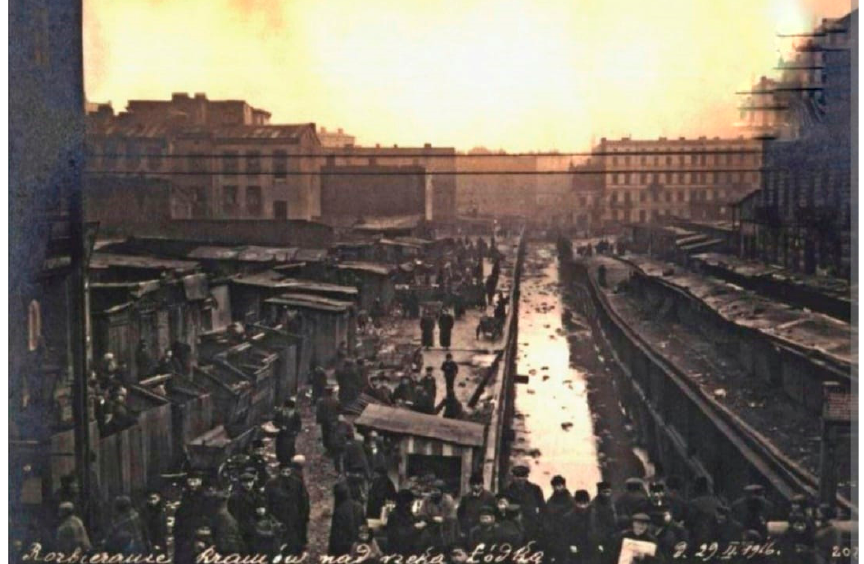
Figure 18. Ł ódka River—1916. Source: fotopolska.eu. Figure 18. Ł ó dka River—1916. Source: